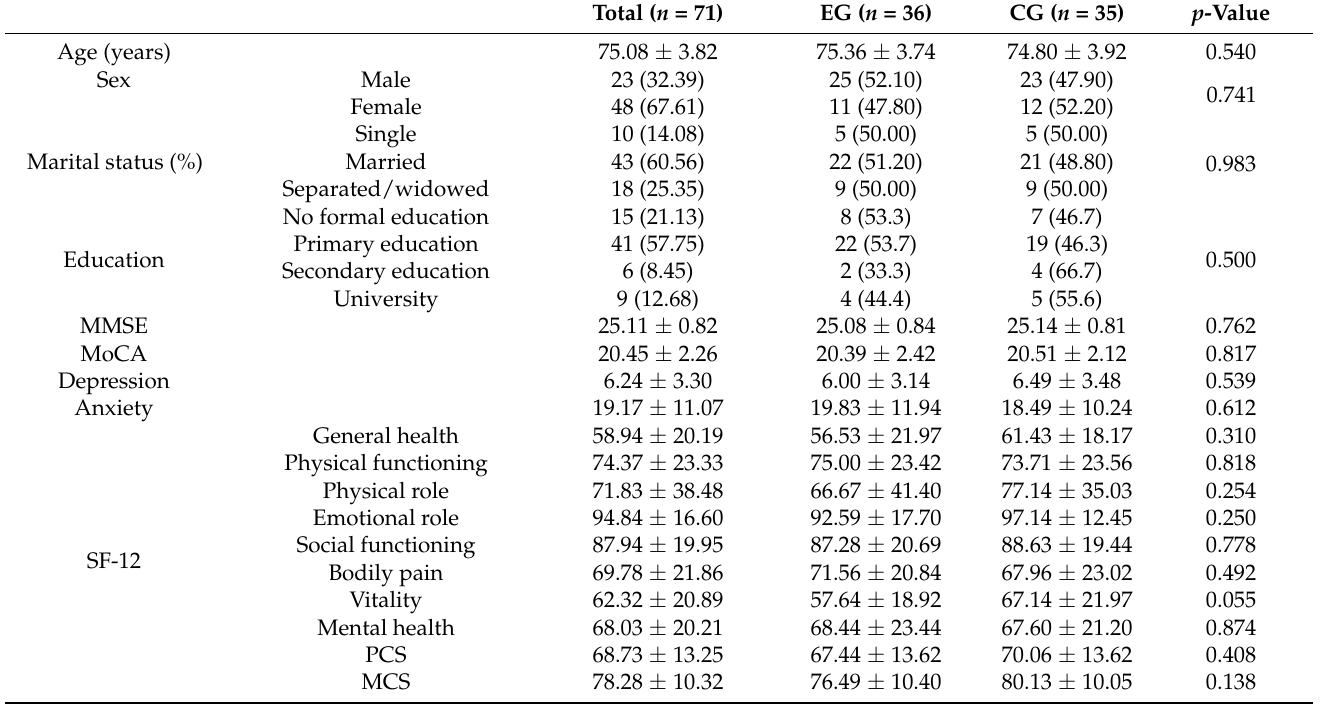
Table 1. Baseline characteristics of study participants.